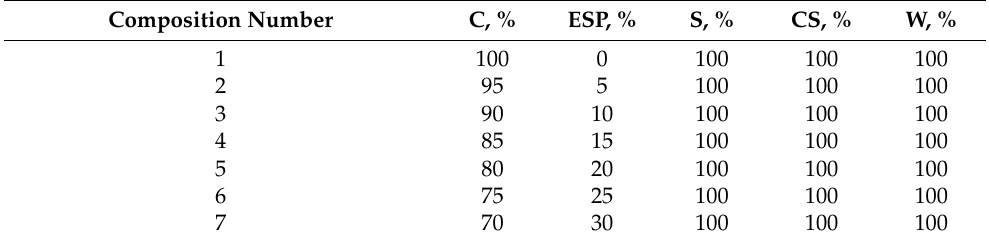
Table 8. Types of experimental compositions.